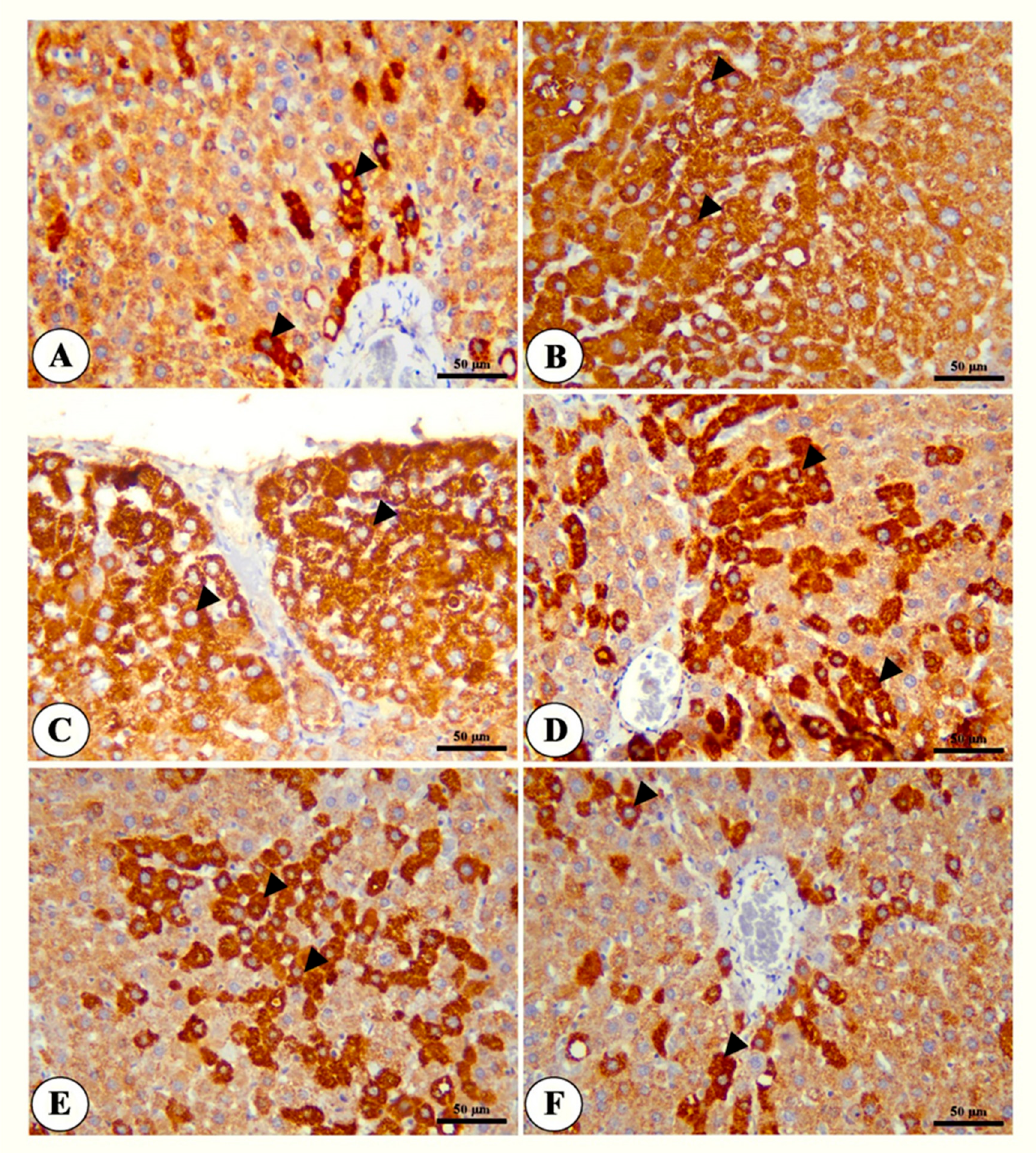
Figure 6. Photomicrograph of liver tissue of control group ( A ), HCC group ( B , C ), NSP=treated group ( D ), sorafenib-treated group ( E ) and NSP + sorafenib-treated group ( F ) showing positive cytoplasmic immunostaining of Hep Par 1 (black arrow heads). Hep Par 1 IHC, Bar = 50 µm.